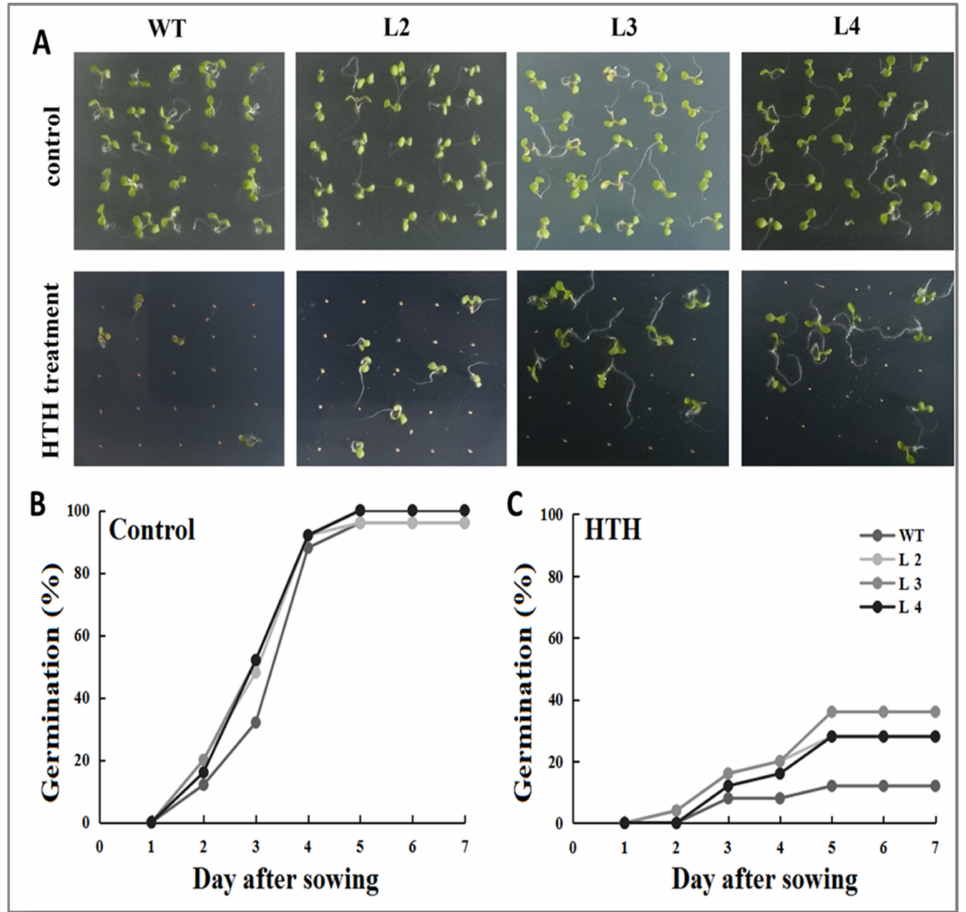
Figure 5. Evaluation of overexpression transgenic Arabidopsis lines and wild-type Arabidopsis seeds germination under HTH stress conditions. ( A ) Seed germination of overexpression transgenic Arabidopsis lines and wild-type Arabidopsis on growing medium under control and HTH stress conditions. ( B , C ) Germination rates of overexpression transgenic Arabidopsis lines and wild-type Arabidopsis seeds under control and HTH stress conditions. Each data point is the average of three experimental